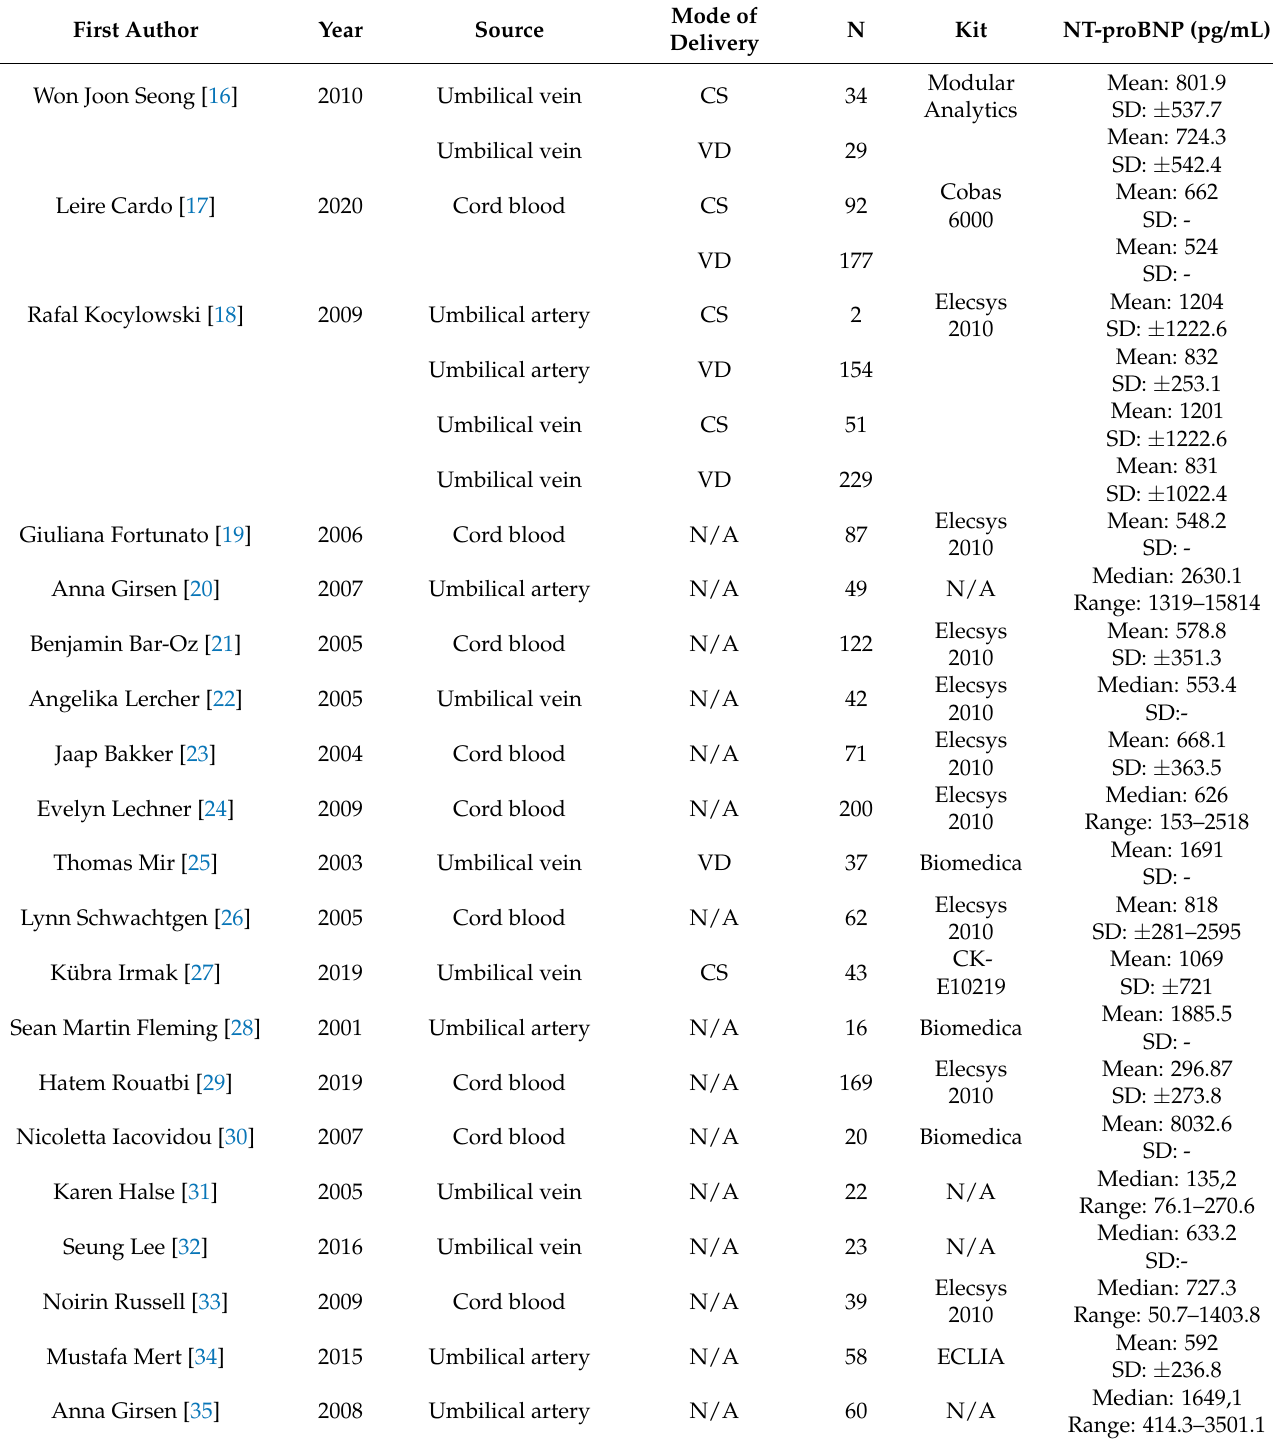
Table 1. Characteristics and results of included studies that report on the values of NT-proBNP in umbilical cord of healthy term neonates (N = 25). N/A: not